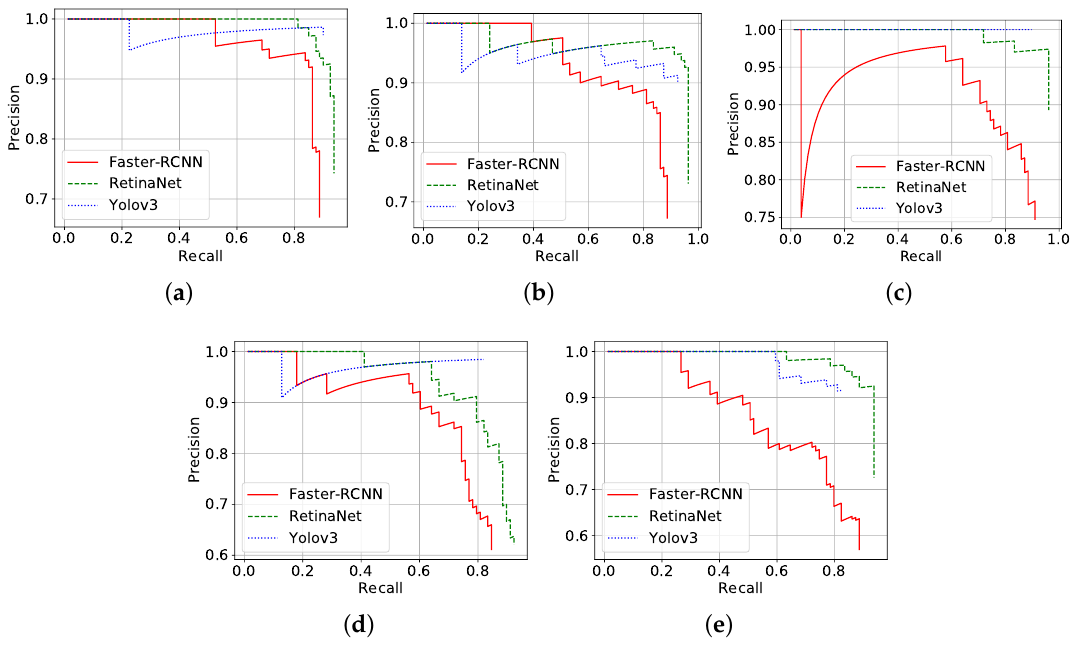
Figure 3. Precision–recall curves of detection methods in all five cross validation rounds ( a – e